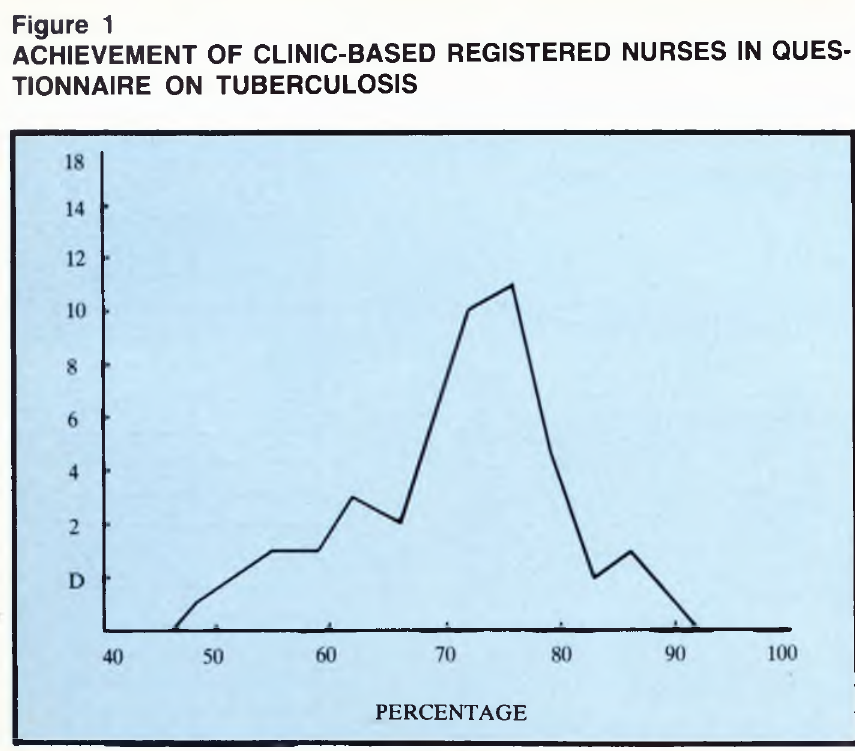
shows results for the clinic-based nurses, figure 2 for the hospital- based nurses and figure 3 for the whole group. The picture for the whole group shows a right-slanting curve between 45 % and 90 % . The median was on 72 % and the mode on 76 %. It thus seems that